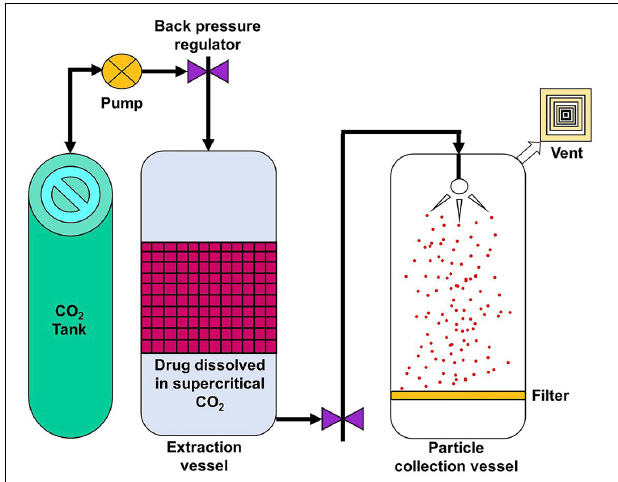
FIGURE 7 | Simple setup of a supercritical fluid technology method, reproduced from Jog and Burgess